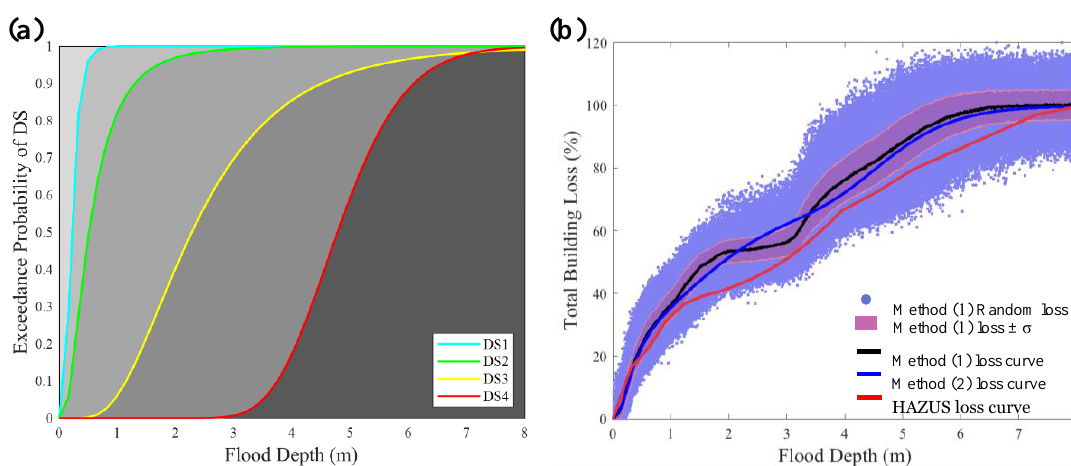
Figure 6. 2D building results for the F10 one-story school building archetype: ( a ) Fragility curves; ( b ) Loss curves.